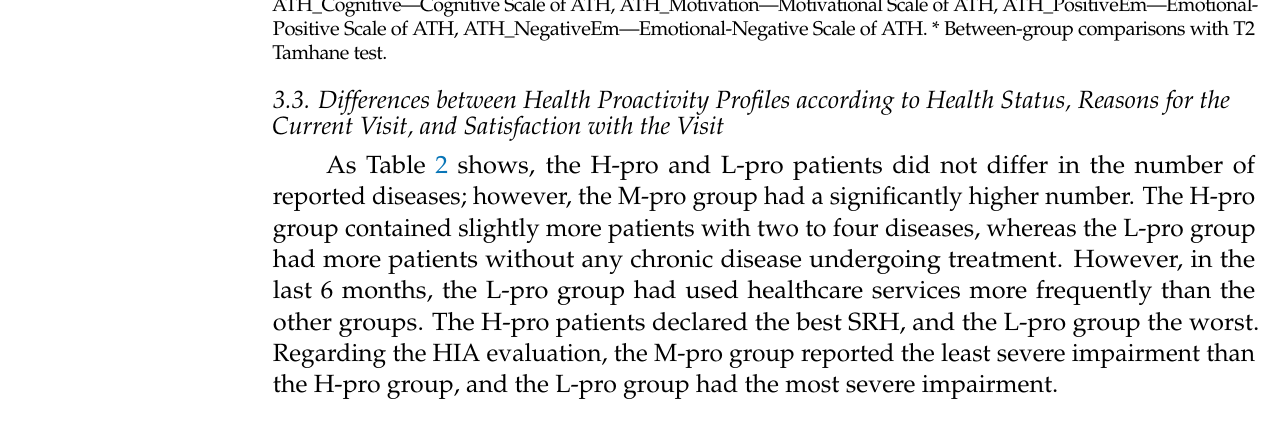
Table 2. Differences between health proactivity profiles according to health status, reasons for the current visit, and satisfaction with the